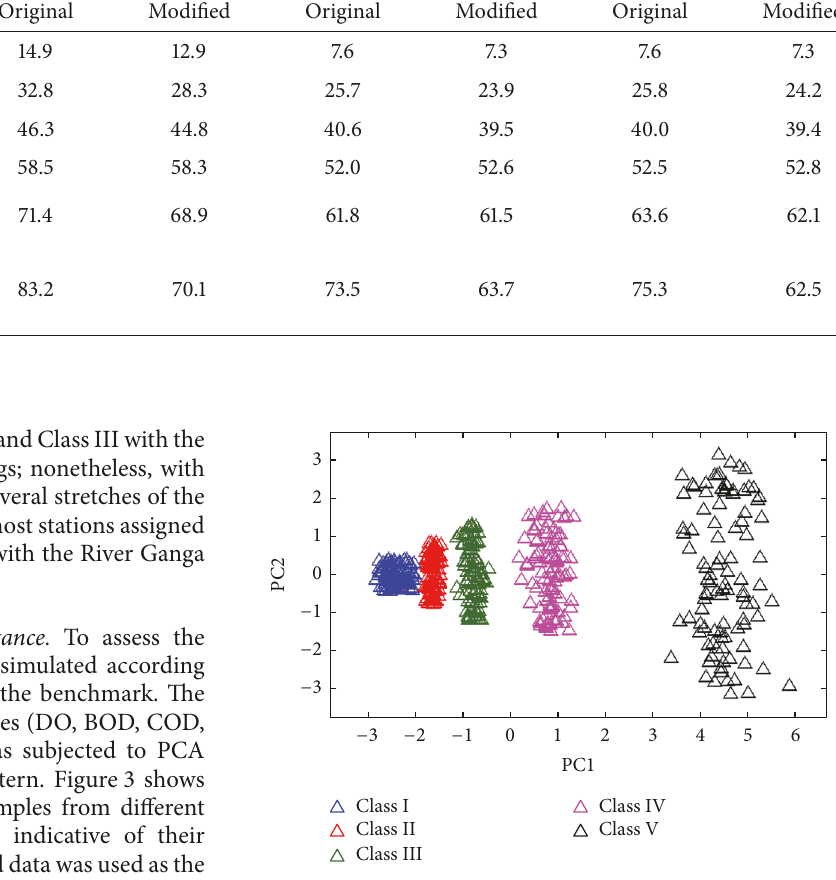
Figure 3: The scores plot of training data with five classes compris- ing eight parameters (DO, BOD, COD, TSS, pH, NH 3 -N, FCC, and